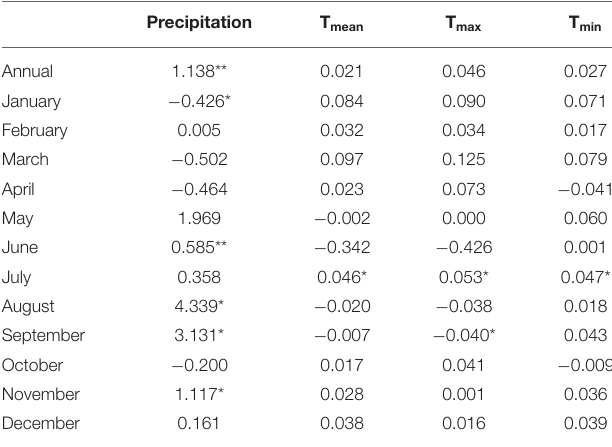
47 ◦ N than south of 47 ◦ N ( Figure 8 ). It confirms that the marsh TABLE 2 | Temporal trends in precipitation (mm/a), T min ( ◦ C/a), T max ( ◦ C/a), and T mean ( ◦ C/a) in marshes of the Sanjiang Plain from 2000 to